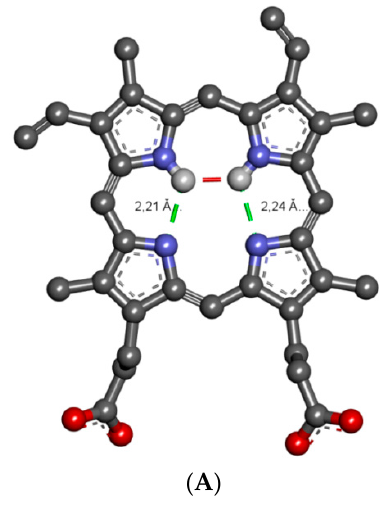
C(8) positions, as well as propionic acid residues in C(13) and C(17). Due to the formation of strong hydrogen bonds with Arg 117 and Tyr 161 (Site 1) and Lys 444 (Site 2), the most significant changes in PpIX conformation are observed. PpIX conformation are observed.